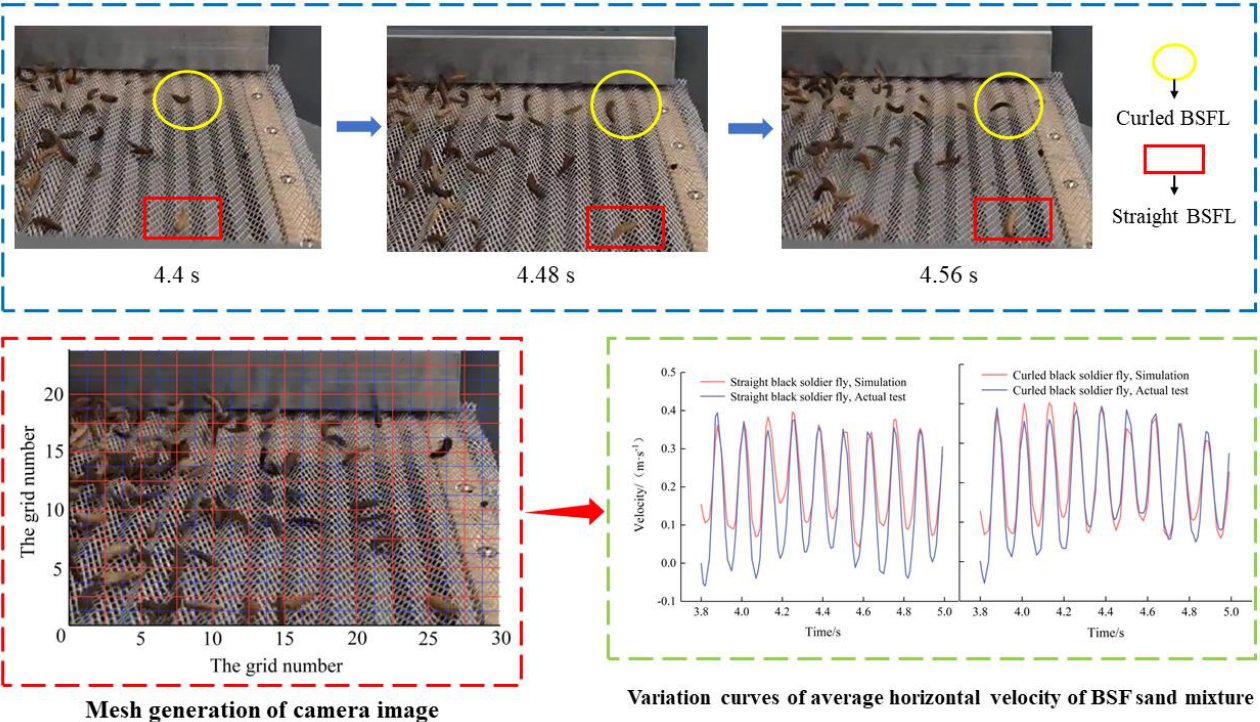
Figure 18. Comparison of actual and simulated images of larvae movement at the screen tail.